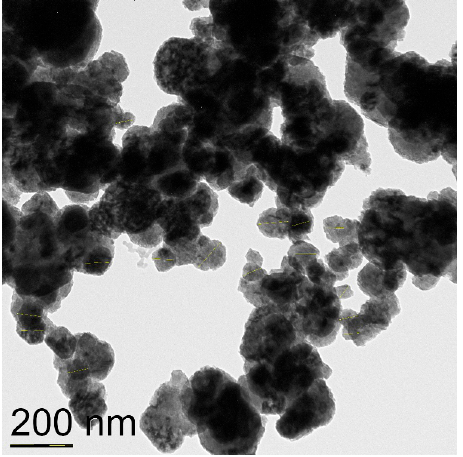
Figure 2. TEM image of CuNPs of the average particles size 72 nm.